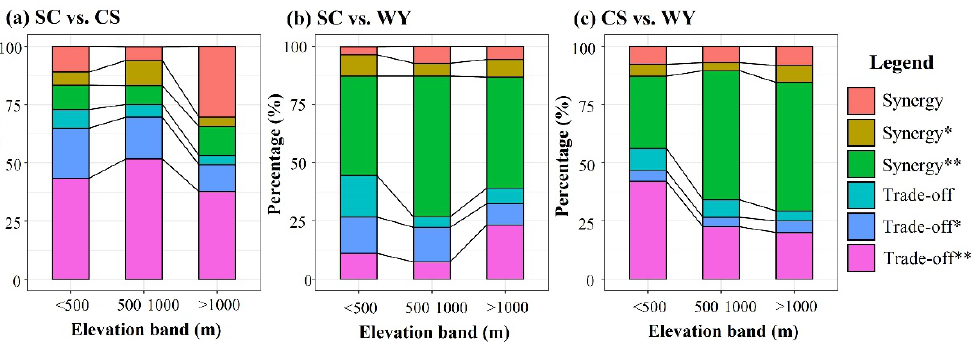
Figure 7. Trade-offs and synergistic of ecosystem services among different vegetation types. C, cropland; BF, broad-leaved forests; CF, coniferous forests; MF, mixed forests; MBF, Moso bamboo forests; G, grass; S, shrub; ( a ) soil conservation and water yield; ( b ) soil conservation and carbon sequestration; ( c ) carbon sequestration and water yield. *: 0.05 < p < 0.10; **: 0.01 < p < 0.05.